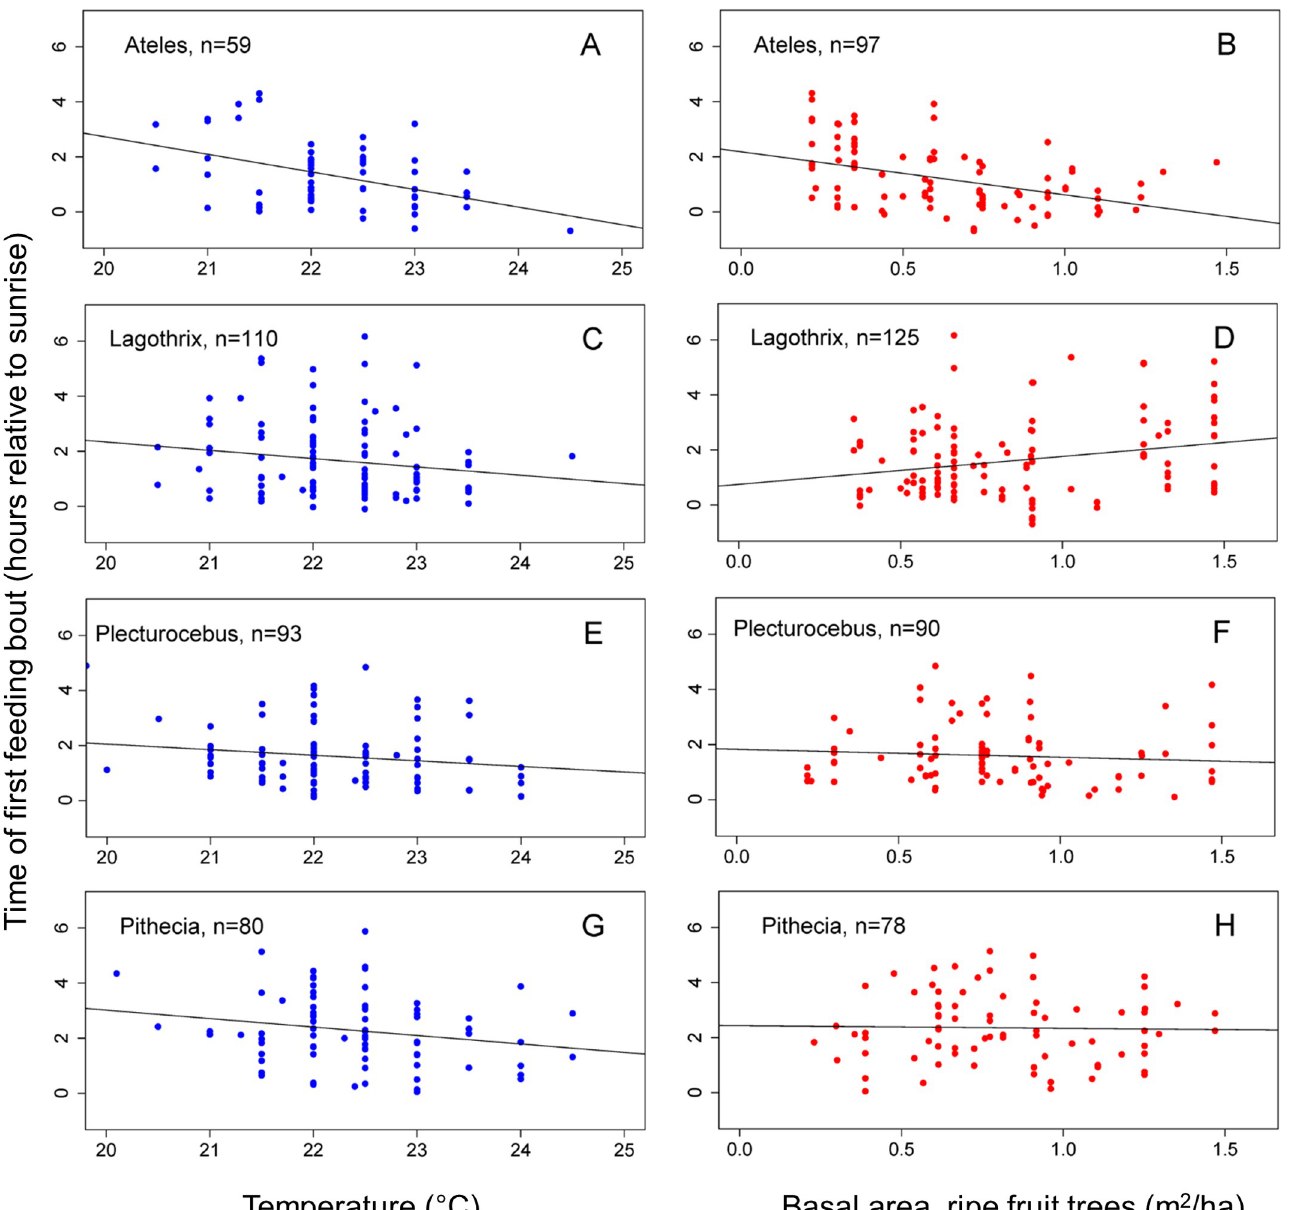
Fig 6. Relationships between times of first feeding bouts and ecological factors. Panels A, C, E, G: Time of first feeding bout as a function of minimum temperature on the day of the observation. Panels B, D, F, H: Time of first feeding bout as a function of ripe fruit abundance in the biweekly period containing the observation day. Least squares regression lines are plotted, based on the displayed